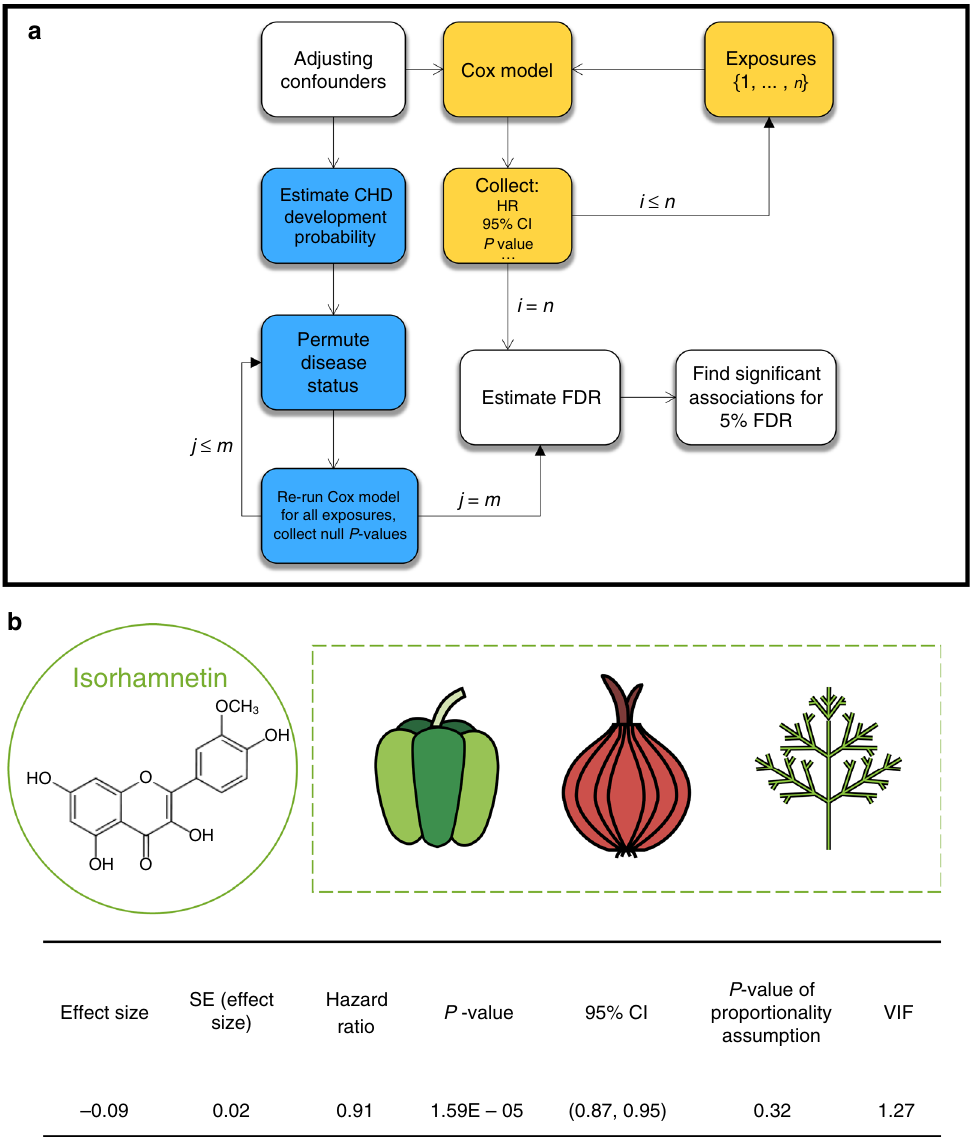
Fig. 2 Ewas Methodology Description and Output. a For each exposure ( i ), we fi t a Cox model to estimate CHD risk, while controlling for a set of adjusting variables ( n exposures, in total). Through this process, we also collect the VIF and the P value regarding the proportionality assumption. After the fi tting phase (yellow), we proceed with the multiple testing protocols (blue). We leverage confounding variables to estimate the likelihood of CHD development for each subject, and the disease status is then permuted accordingly, m times. For each exposure, the FDR is estimated, and associations with an FDR < 0.05 are considered statistically signi fi cant. b Isorhamnetin is an O-methylated fl avonol from the class of fl avonoids mainly found in green pepper, red onion, and dill. EWAS shows that isorhamnetin intake is negatively associated with CHD risk (HR: 0.91; 95% CI: 0.87 – 0.95; P value 1.59 × 10 − 5 , from two-sided Wald test, with no adjustment for multiple comparisons). The P value regarding the proportionality assumption indicates the appropriateness of using the Cox model. The VIF of 1.27 is an indication of the absence of severe